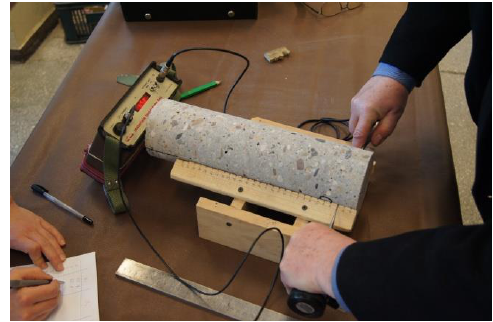
Figure 2. The measurement of velocity C L of longitudinal ultrasonic wave. Table 2. Velocities C L ultrasonic wave propagation, measured in two perpendicular directions in core samples taken perpendicularly to top surface of slab.